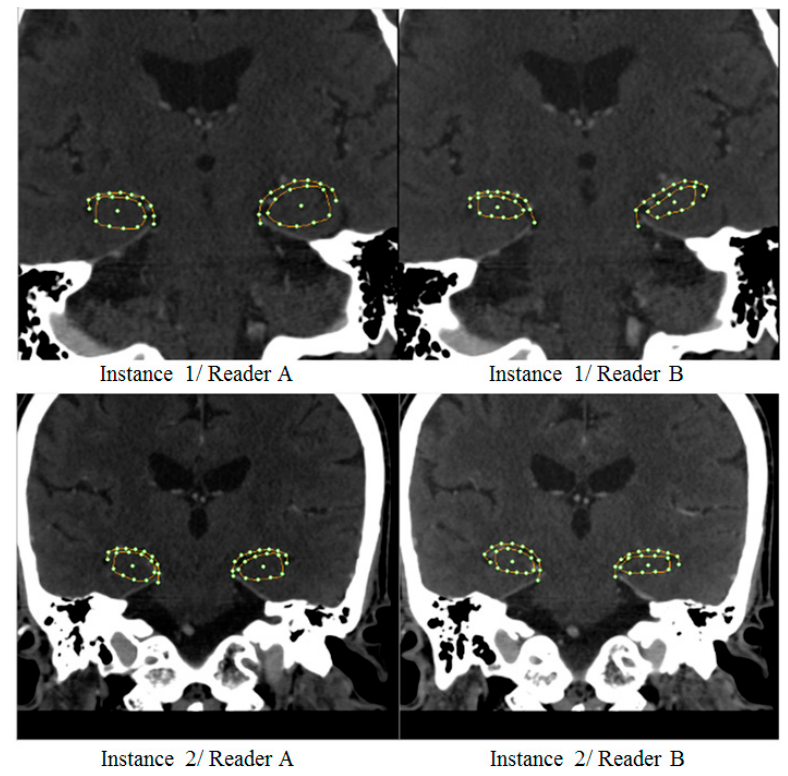
Figure 3. Example of large ( top ) and small ( bottom ) degree of inter-reader variabilities.